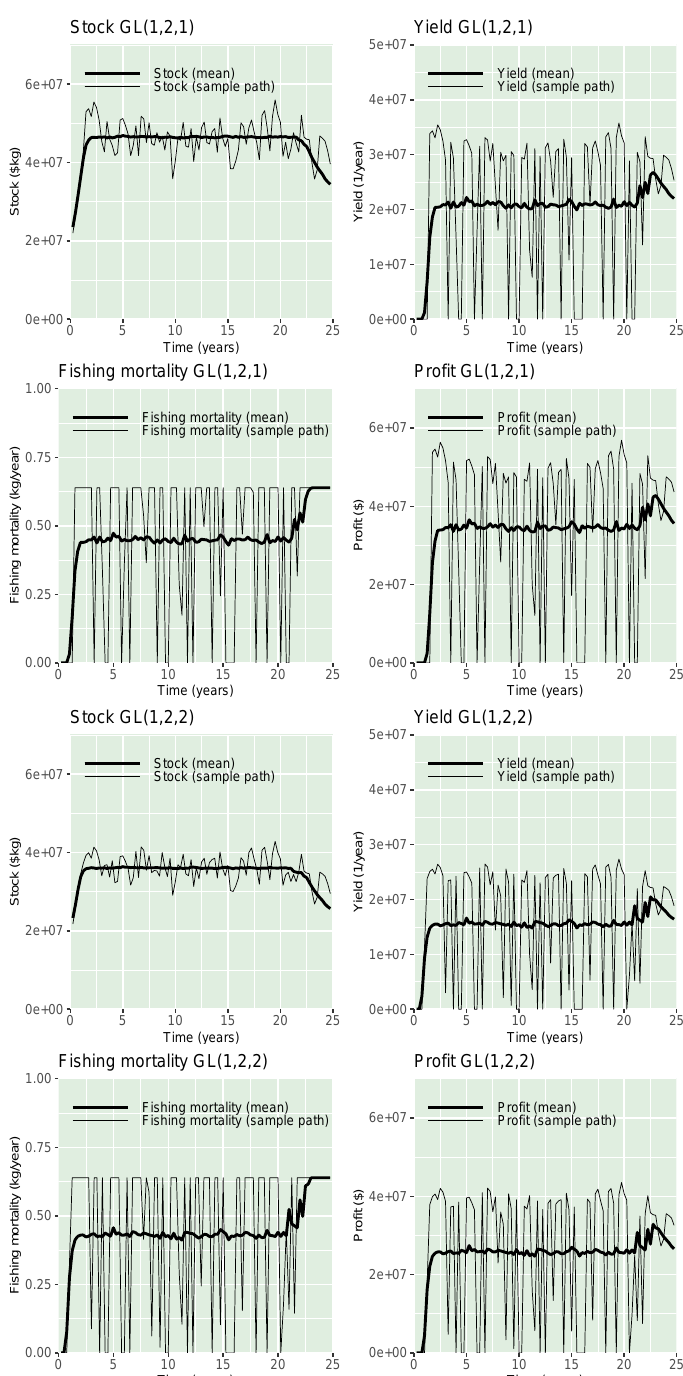
Figure 3. Stock, fishing mortality, yield, and profit sample paths (thinner line) and mean (ticker line) obtained by the application of models GL ( 1,2,1 ) ( top panel) and GL ( 1,2,2 ) ( bottom panel). Unit values are described in Table